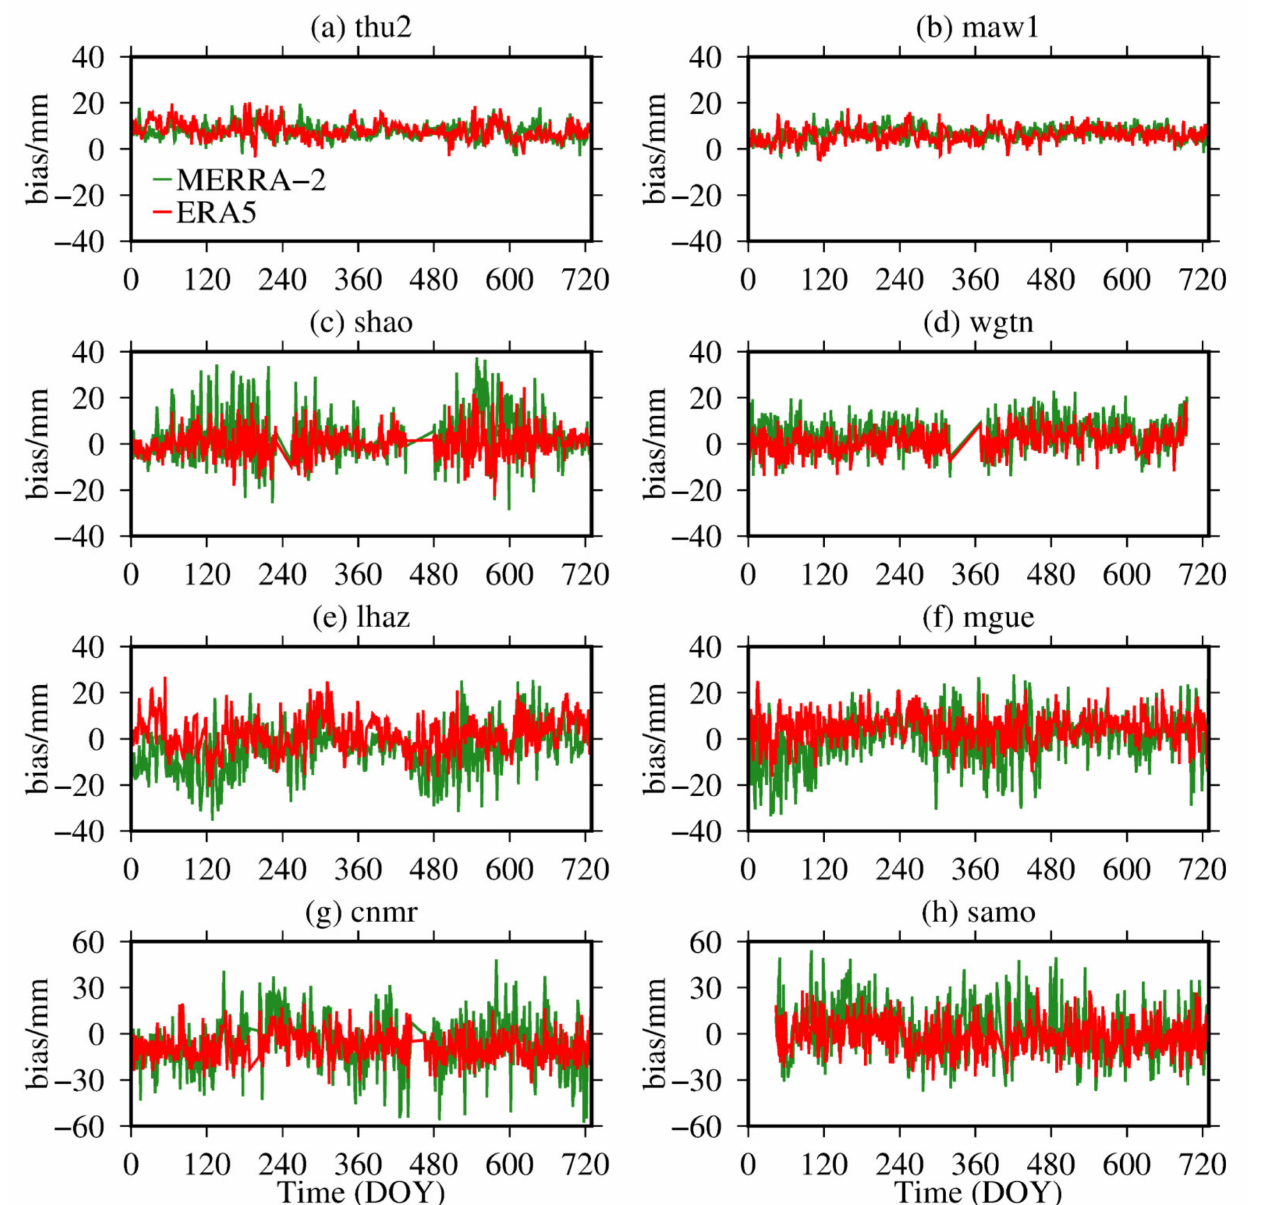
Figure 4. ( a – h ) Time series of MERRA-2 and ERA5 pressure-level ZTD bias in 8 GNSS